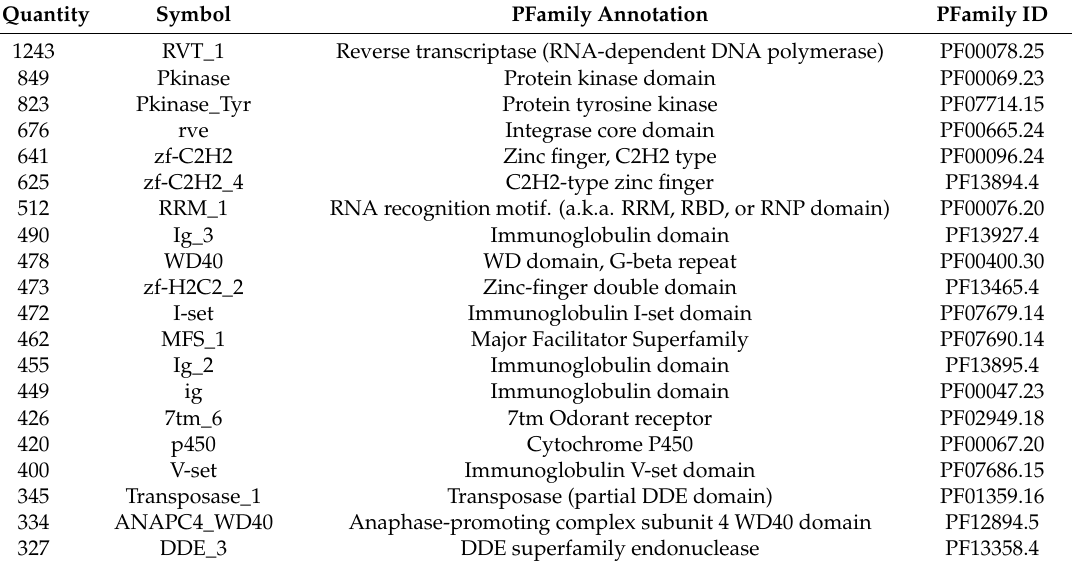
Table 2. Top 20 most numerous